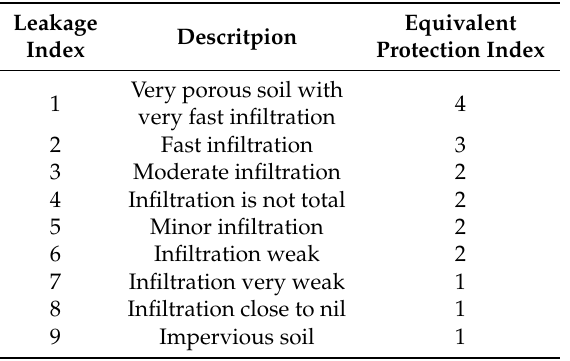
Table 1. Soil protection index according to soil leakage index.